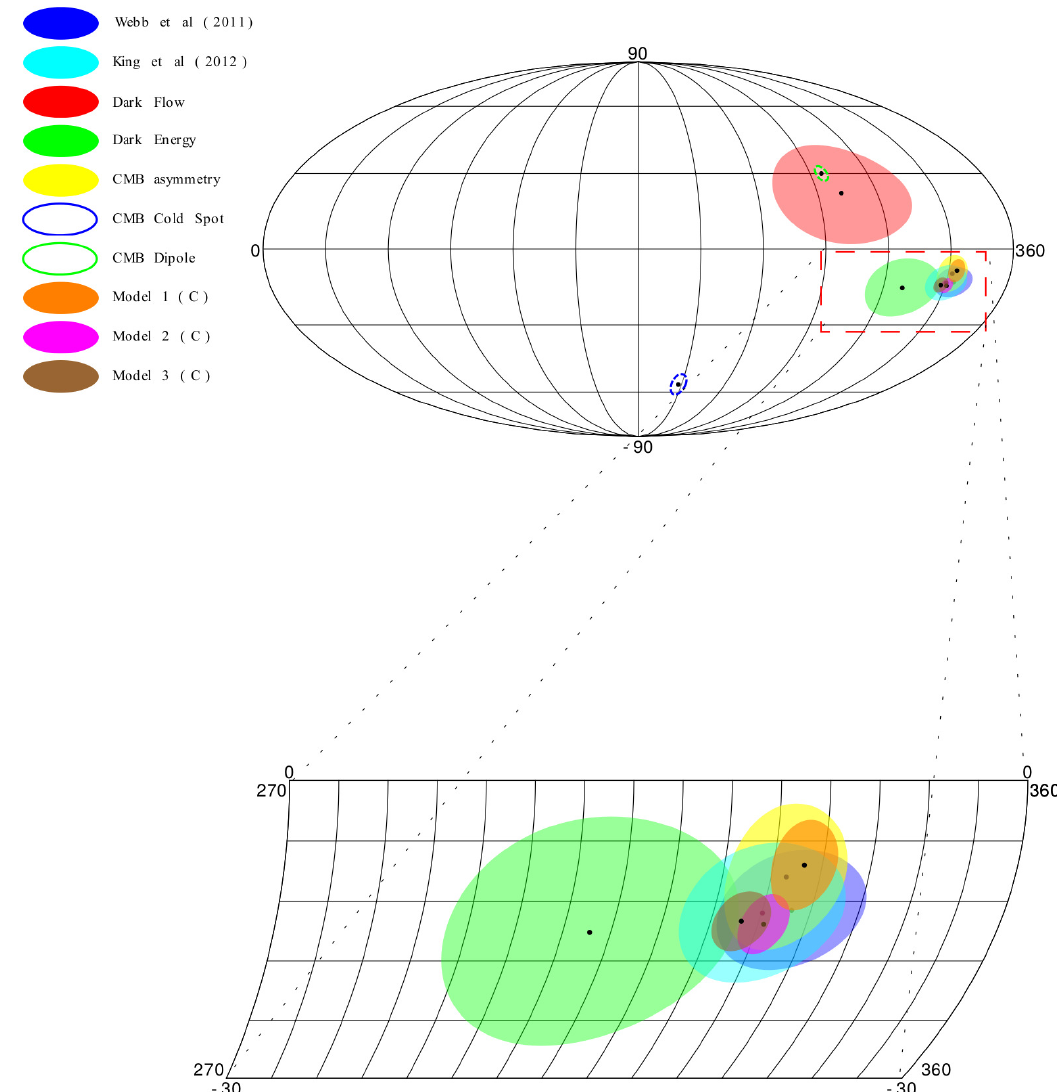
Figure 1. Directions in galactic coordinates for the spatial variation of the fine structure constant from [1,2] in blue and cyan, respectively, for the Dark Energy dipoles from [6] in green, Dark Flow direction from [27,30–33] in red, for the Cosmic Microwave Background (CMB) asymmetry from [7] in yellow, and for our results from the analysis (C) of models 1,2 and 3 in orange, magenta and brown, respectively. Finally, we also indicate in blue and green dashed circles the direction of the Cold Spot anomaly and the intrinsic CMB dipole, respectively